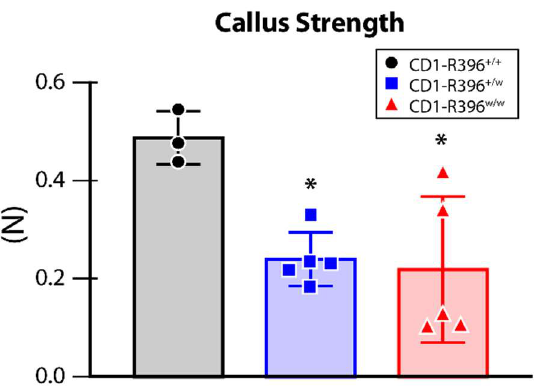
Results are means ± S.D. Ratio 25:24,25, ratio of 25(OH) 2 D 3 concentrations over 24,25(OH) 2 D 3 concentrations. n.d., non-detectable. **, p < 0.01; ***, p < 0.001; # , p < 0.0001 vs. corresponding wild-type sex within strain by 2-way ANOVA and Sidak’s post hoc test.